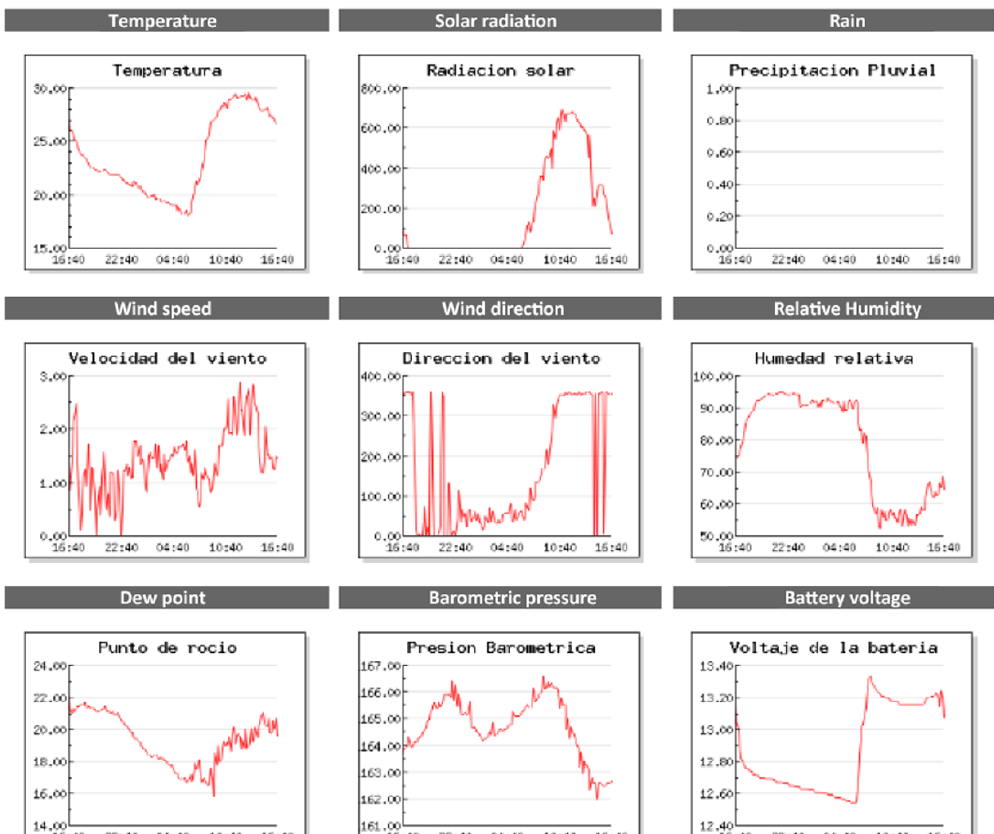
Figure 17. Graphical representation of the acquired